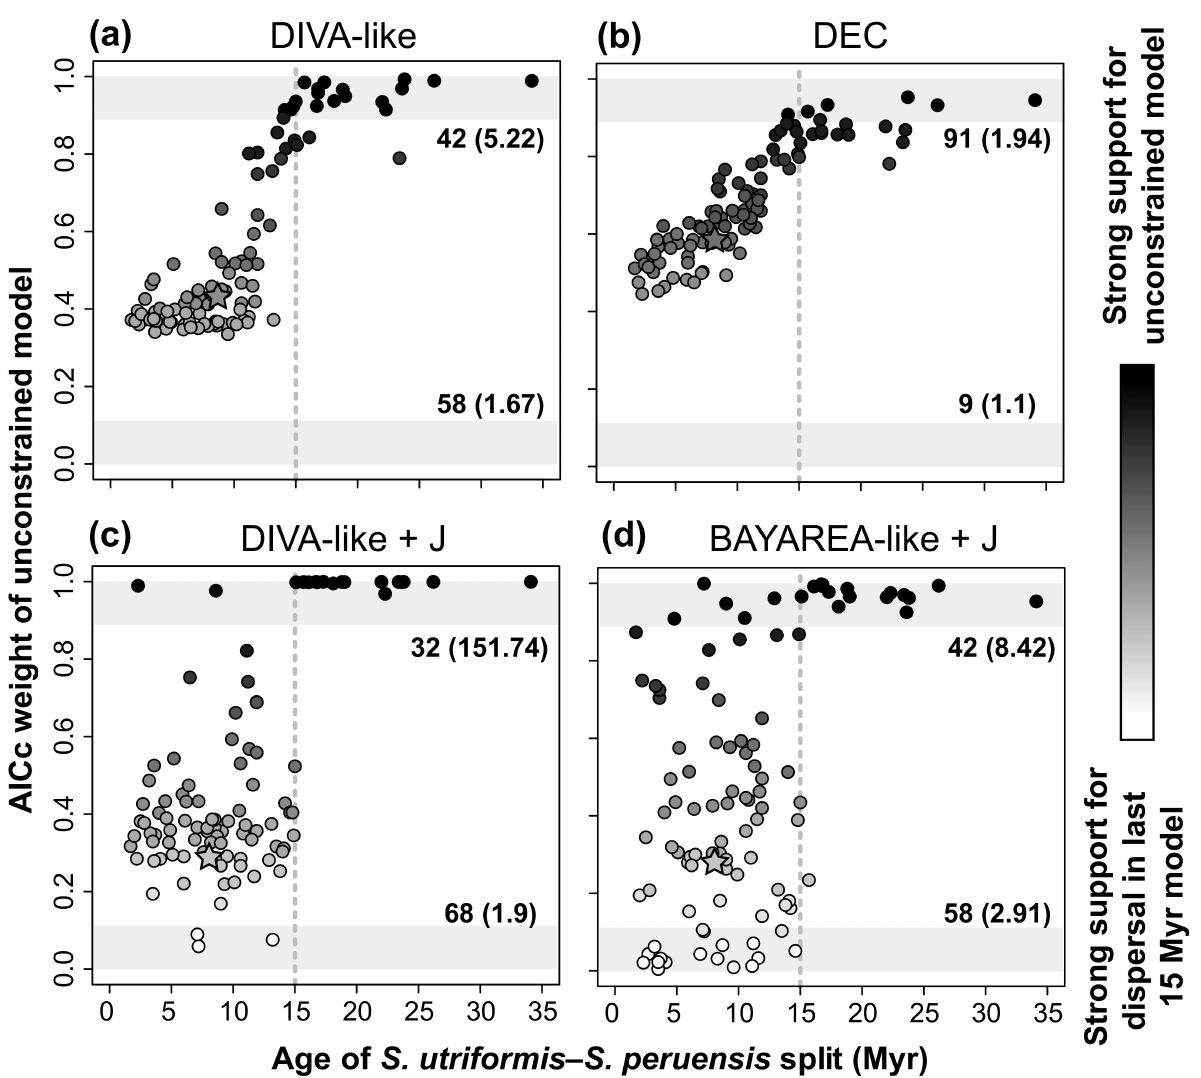
Figure 5. Relationship between AIC weight of the unconstrained biogeographic model allowing for dispersal of the Galapagos at any time (relative to the time-stratified model allowing dispersal only during the last 15 Myr) and the age of split of Sicarius utriformis (from Galapagos) and its sister species. Each dot represents an individual tree of a sample of 100 taken from the posterior distribution of a Bayesian analysis; the star represents the maximum clade credibility tree. Values of AIC weight close to 1 (darker shades) indicate strong support for the unconstrained model, while values close to 0 (lighter shades) indicate strong support for the time-stratified model. The light grey areas at the top and bottom of the graphs are the zones where the support for one of the alternative models is decisive. The dashed vertical line indicates the boundary between time slices in the time-stratified analysis. Numbers at the top and bottom of the graph are the number of trees supporting each model, and the median support relative to the alternative model. Trees in which the split between S. utriformis and its sister species are older than 15 Myr fit better to an unconstrained scenario allowing occupation of the Galapagos before that